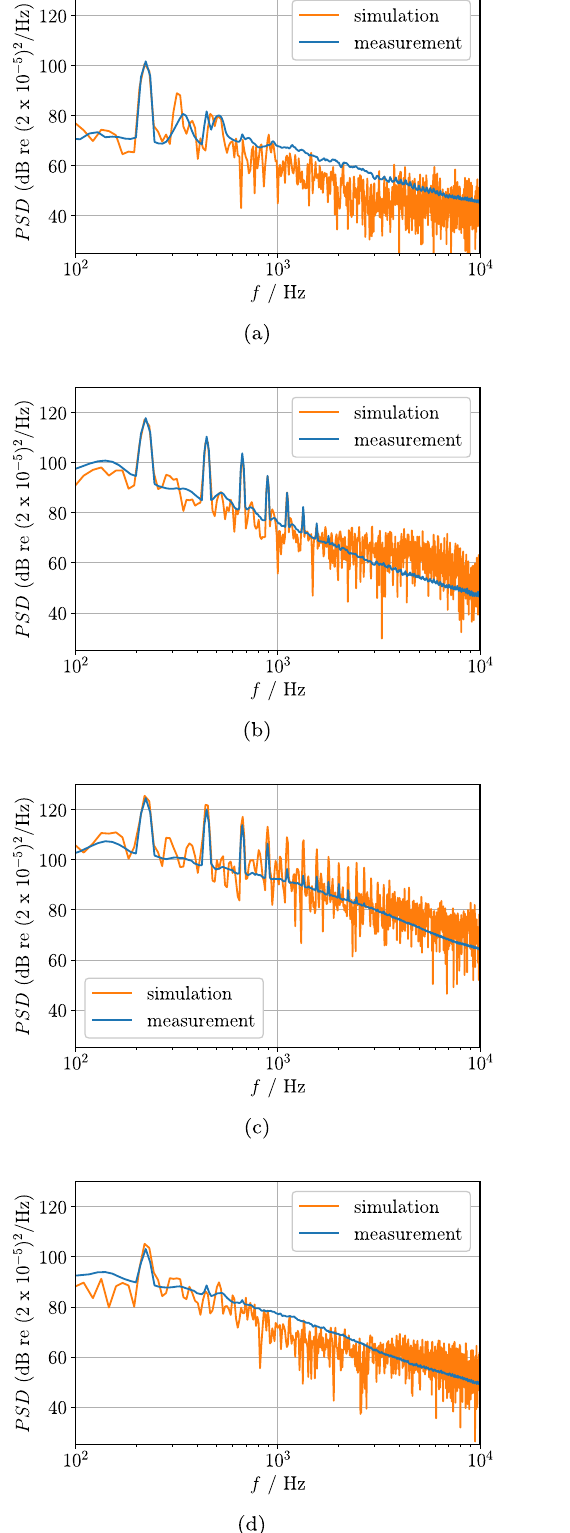
Figure 16. Comparison of wall pressure fl uctuations from measurement and simulation (0.1 s). (a) Measurement position 2. (b) Measurement position 7. (c) Measurement position 9. (d) Measurement position 13.